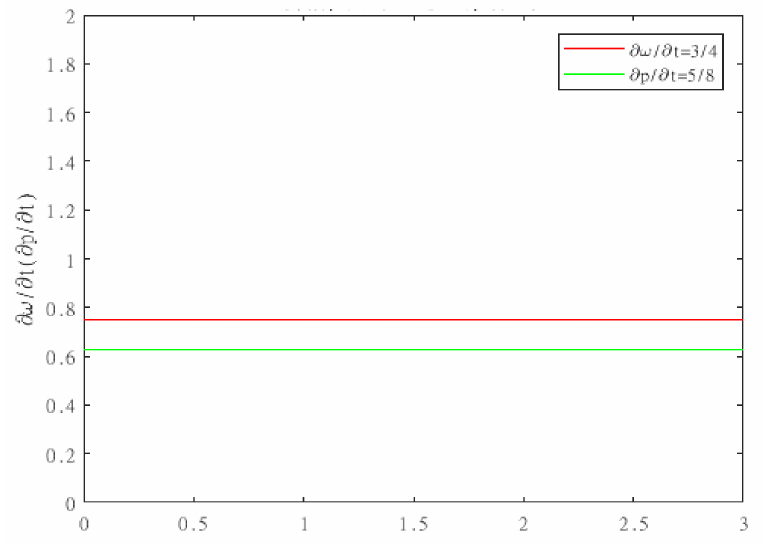
Figure 5. Price change rates for the intermediate and final products in response to a specific